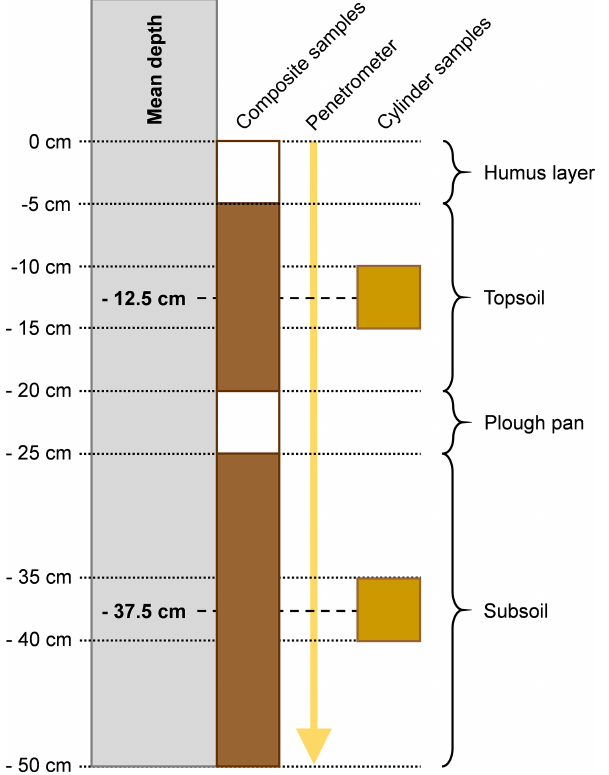
Figure 1. Schematic overview indicating soil layers and respective depths used for composite samples, penetrometer insertions, and cylindrical soil core